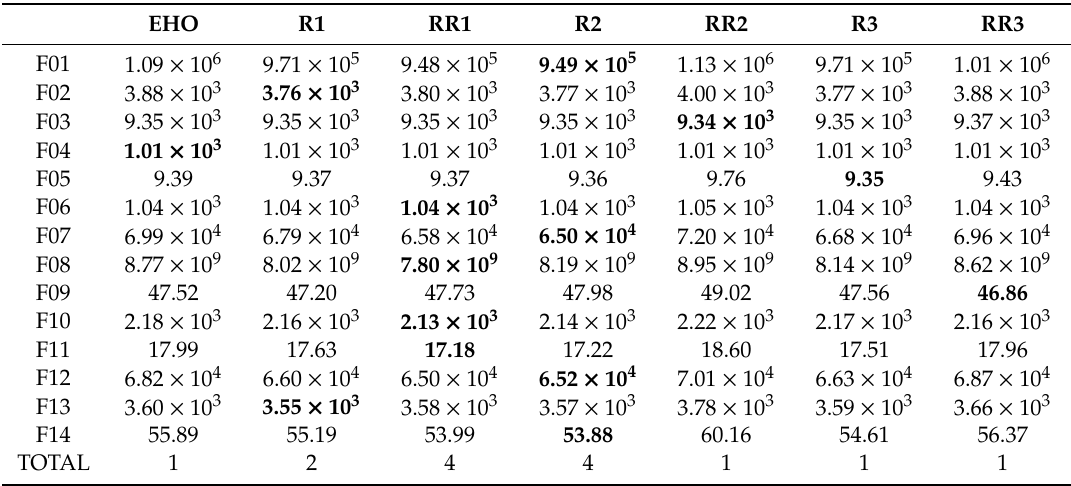
Table 16. Mean function values obtained by EHO and six improved methods on fourteen CEC 2017 constrained optimization functions with D = 100.